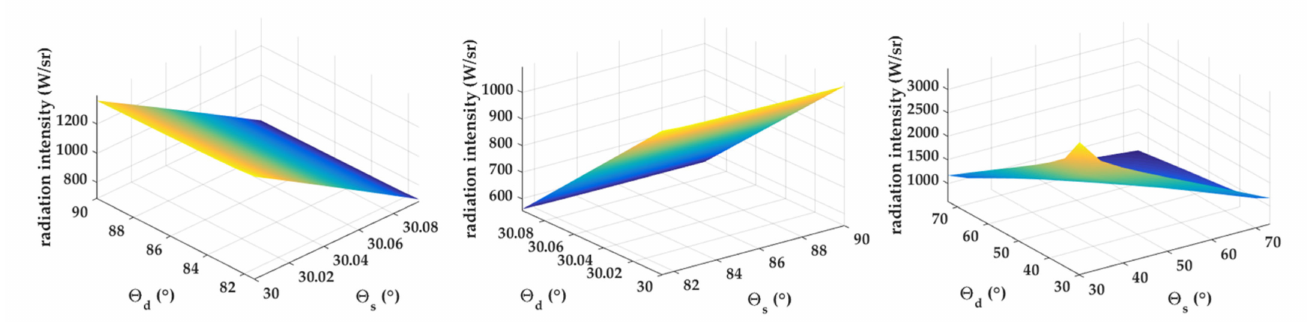
Figure 3. Under the condition that the value of the phase angle is 80 ◦ and the value of the conical target inclination is 60 ◦ , this three-dimensional map shows the radiation intensity in each case. (from left to right: Case 1, Case 3, Case